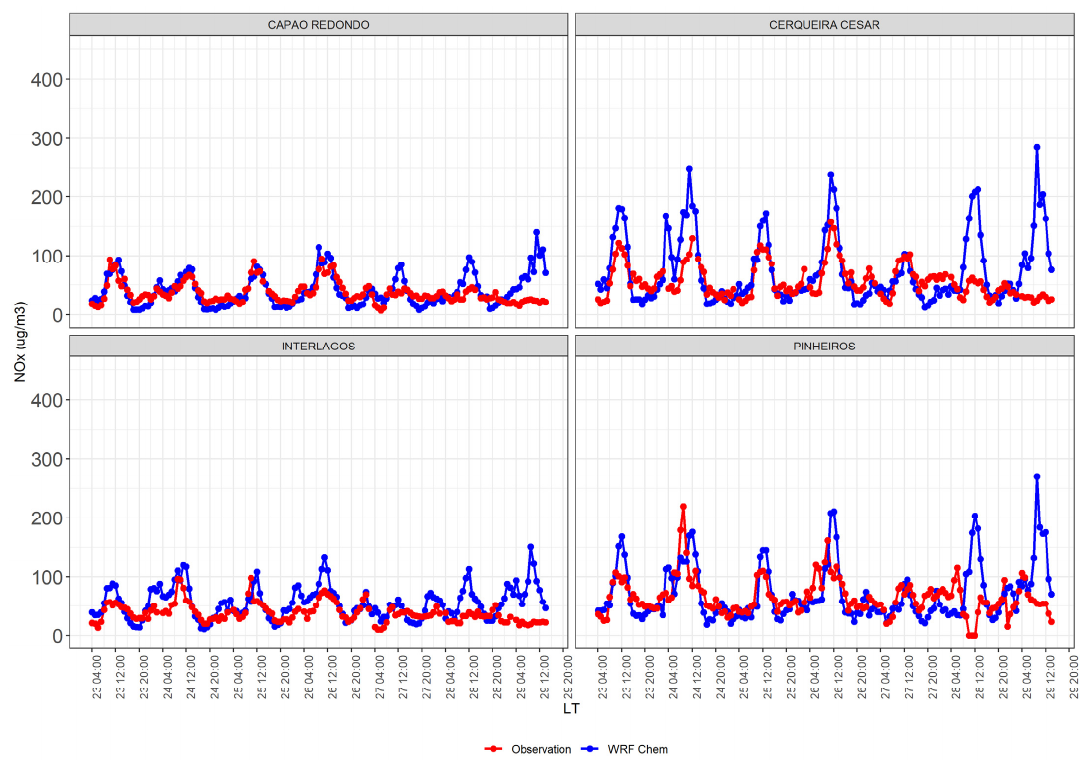
Figure 4. Concentrations of NO X ( μ g/m 3 ) for the stations Capão Redondo, Cerqueira Cesar, Interla- gos and Pinheiros during April 2018.